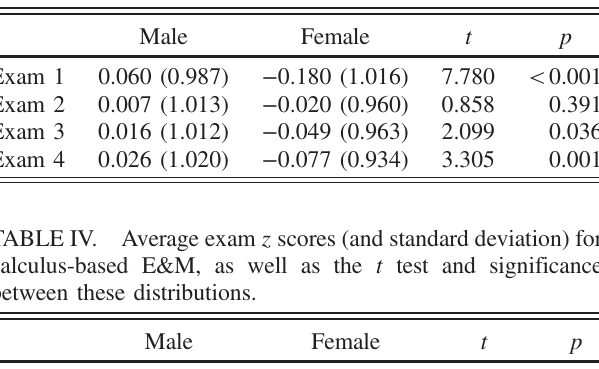
TABLE III. Average exam z scores (and standard deviation) for calculus-based mechanics, as well as the t test and significance between these distributions.